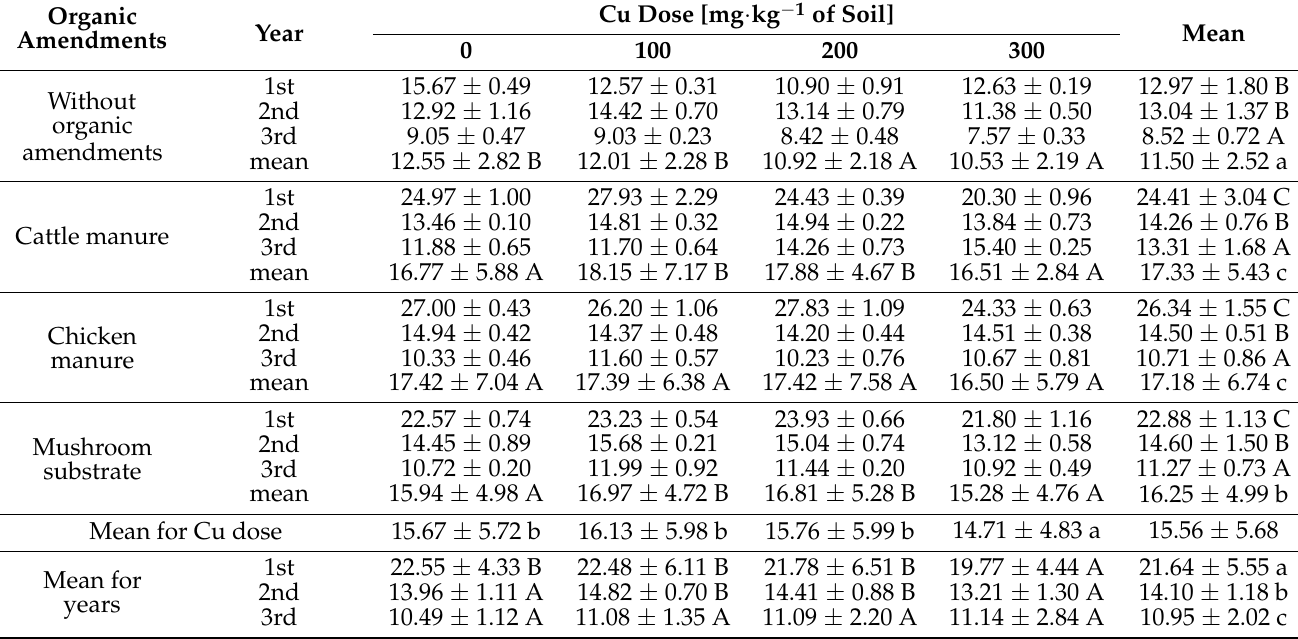
Table 2. Cocksfoot yield, g · pot − 1 (mean ± SD).